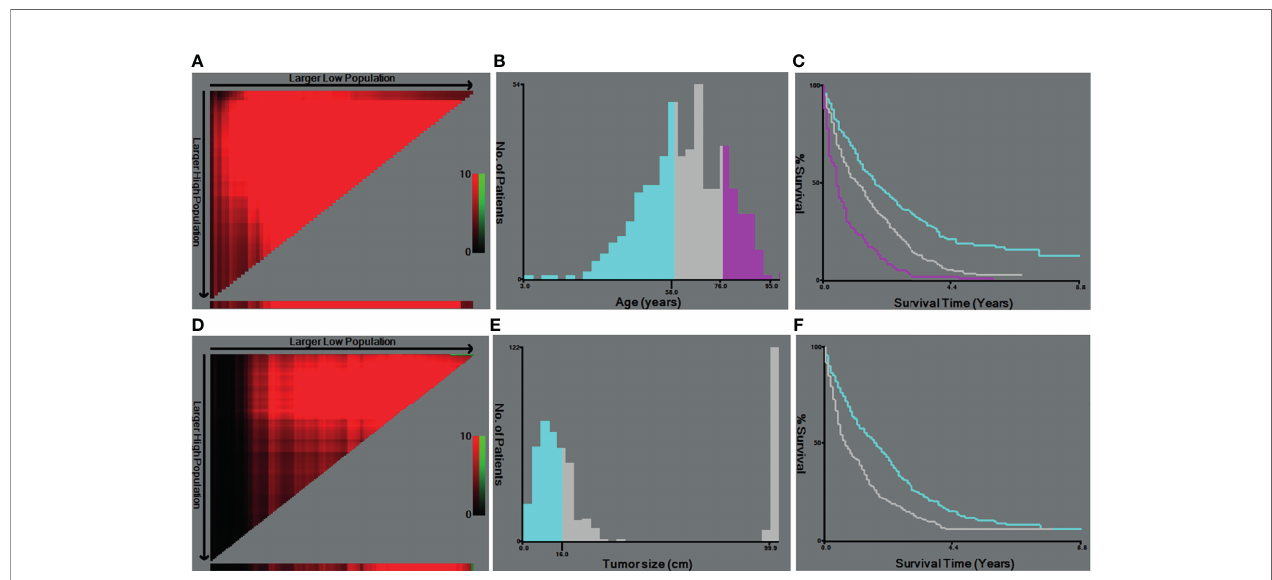
FIGURE 2 | The optimal cutoff values of age and tumor size identi fi ed by X-tiles software. (A, B) The optimal cutoff value of age. (C) The Kaplan – Meier curves for the subgroups of age (<57, 58 – 75, >76) for OS. (D, E) The cutoff value of tumor size. (F) The Kaplan – Meier curves for the subgroups of tumor size (<1.6 cm, ≥ 1.6 cm) for ROC, receiver operating curve; OS. OS, overall